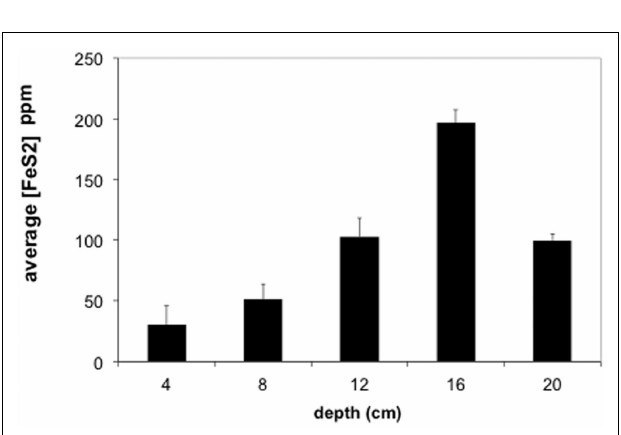
FIGURE 5 |Average concentrations of pyrite (FeS 2 ) in Stege Marsh sediments. Pyrite concentrations are given as parts per million (ppm). Error bars represent one standard